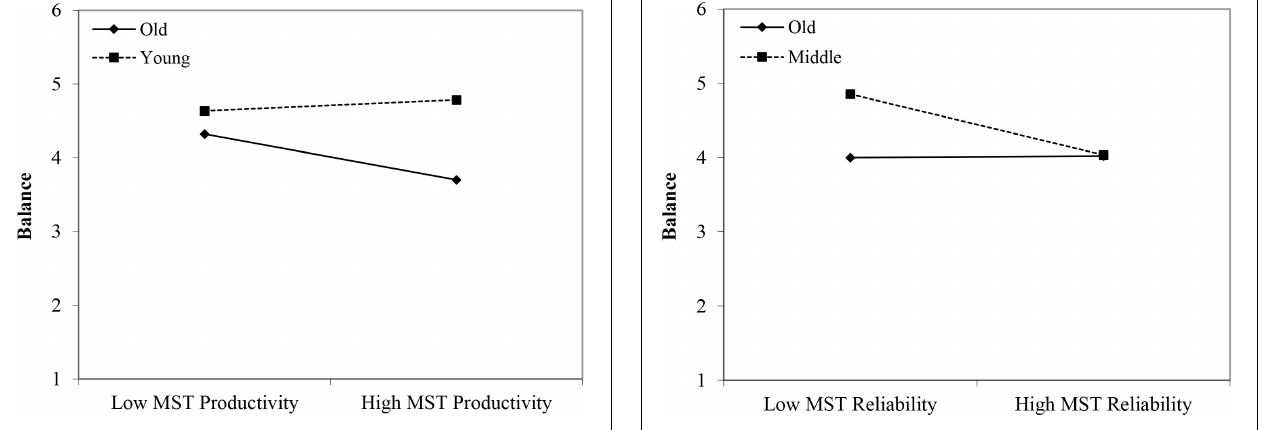
FIGURE 11 | Interaction between perceived age-based (meta-)stereotyping productivity and age groups: Predicting balance. Low = –1 SD , High = + 1 SD , MST = perceived age-based (meta-)stereotyping, old = older workers, young = younger workers.